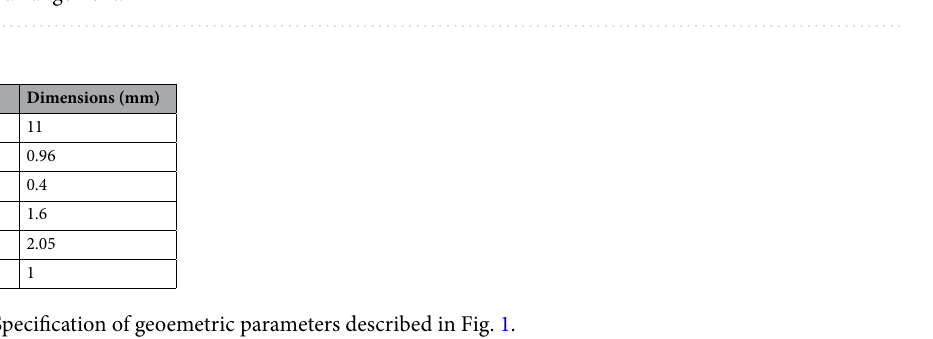
Figure 2. Schematic design illustration of anti reflecting metasurface on top of FR-4 substrate backed by metallic ground plane. Inset shows supercell arrangement of four adjacent elements of split rings in mirror symmetric arrangement.